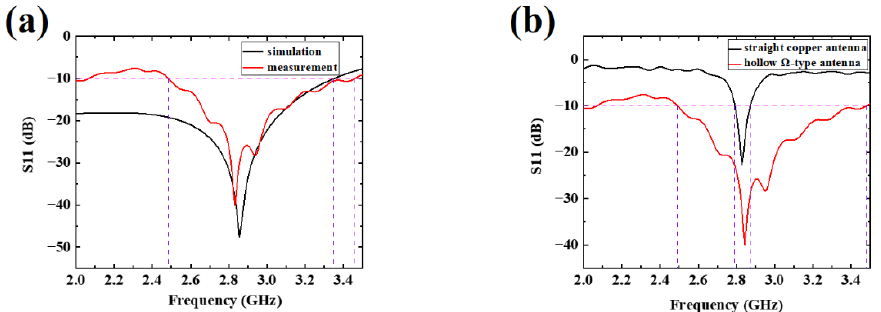
Figure 5. ( a ) Measured and simulated values of S11; ( b ) S11 measured values of two